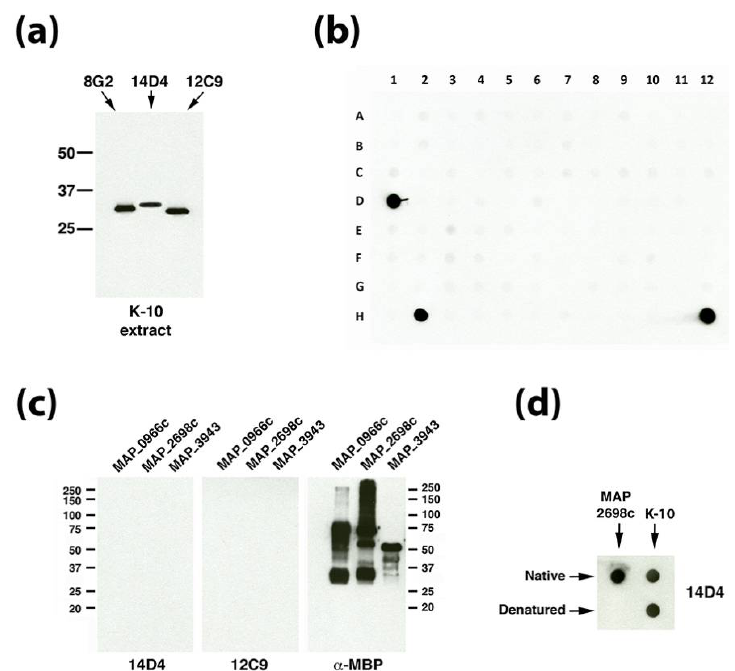
Figure 2. MAP_2698c reacts with mAb 14D4 through a conformation epitope. ( a ) Immunoblot analysis with mAbs 14D4 and 12C9 on the whole cell extract of Map K-10 shows the similar molecular sizes of each protein. These are compared to the 8G2 mAb that binds to the major membrane protein (MAP_2121c, [8]), which has a calculated molecular weight of 33.6 kDa. ( b ) Dot blot array containing 355 spotted recombinant proteins (see supplemental Table S1 for spot assignments) was exposed to 12C9 and 14D4. While spots D1 and H12 contain positive controls, spot H2 contains a mixture of recombinant proteins MAP_0966c, MAP_2698c and MAP_3943. ( c ) Three identical immunoblots of each recombinant protein are exposed to mAbs indicated beneath each blot. MAbs 14D4 and 12C9 show no reactivity to any proteins while the α -MBP control, which binds to the affinity tag, shows proteins are heavily loaded and immunoreactive. ( d ) Dot blot analysis demonstrates that 14D4 reacts with the recombinant MAP_2698c, but only under native conditions. The native protein from the K-10 extract is not subject to this limitation. Kilodalton molecular size markers are indicated in ( a ) and ( c ).